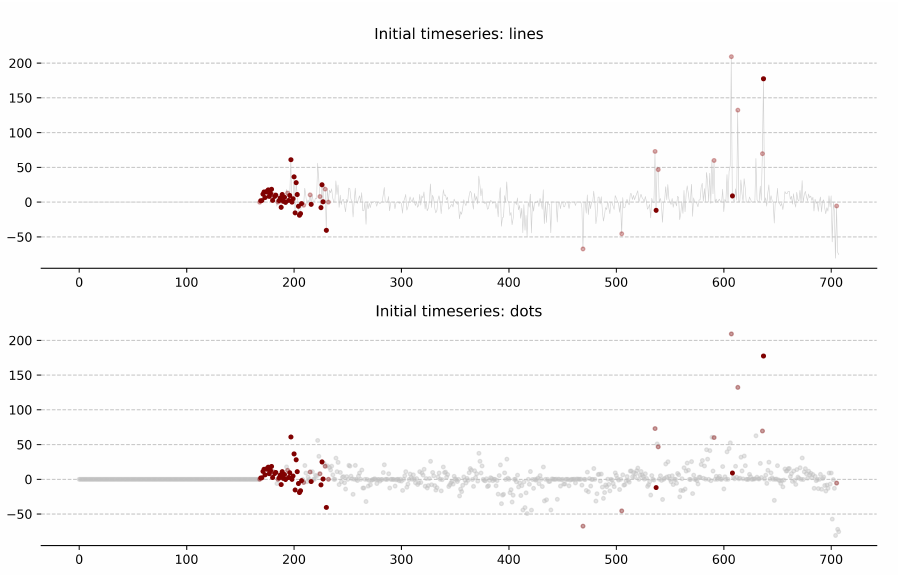
Figure 15. SIEM SPLUNK Machine Learning Toolkit, another example time series without a sea- sonal